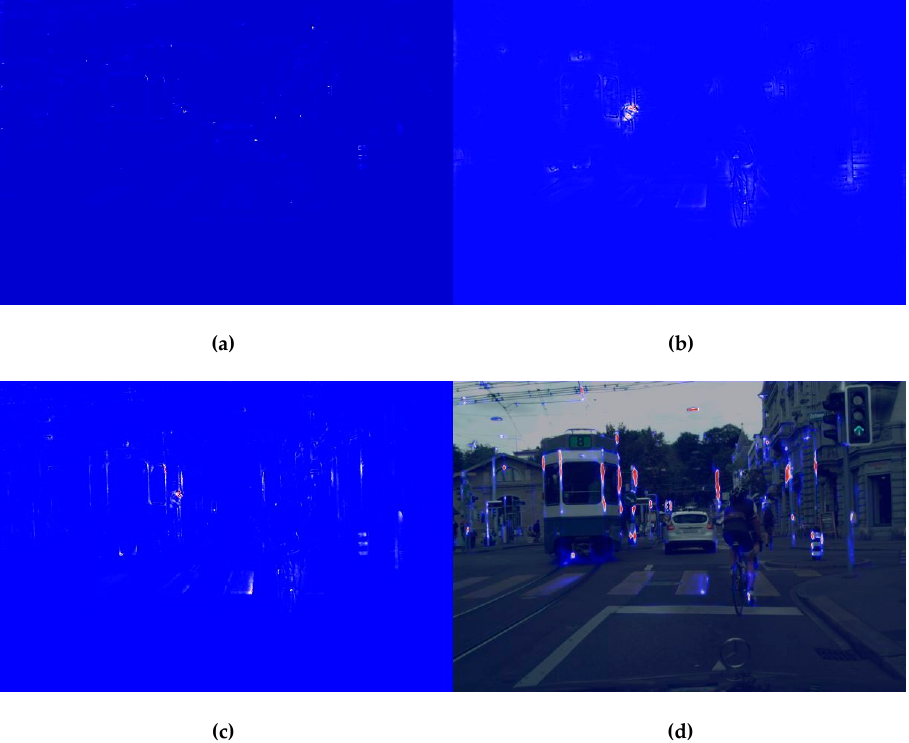
Figure 9. Guided Grad-CAM visualizations for class ‘pole’ on different layers of a model: ( a ) early layer, ( b ) middle layer, ( c ) final layer, ( d ) segmented image.